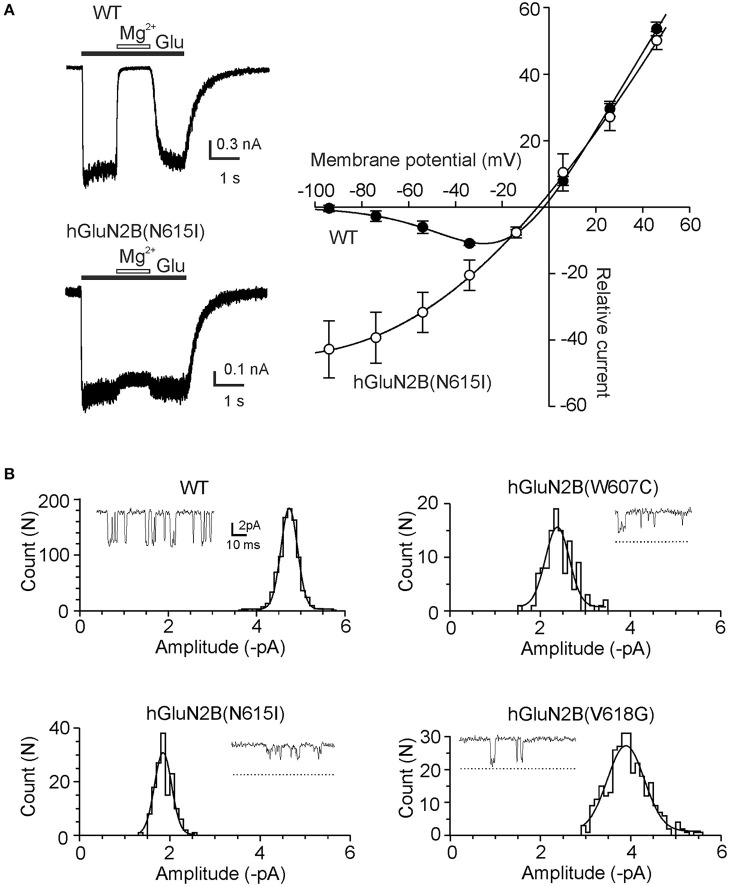
Mutations in the channel pore alter ion permeation. (A) Effect of Mg2+ on WT and hGluN1/GluN2B(N615I) receptor responses. Whole-cell current responses were induced by 1 mM glutamate in the absence and presence of 1 mM Mg2+ at a holding potential of −60 mV. I-V relations without Mg2+ were fit by a linear equation and normalized to have a slope of 1. Corresponding responses recorded in the presence of Mg2+ were normalized and fitted to the Boltzmann equation (Equations 6–8). (B) Examples of single-channel openings induced in WT, hGluN1/hGluN2B(W607C; N615I; and V618G) receptors by 1 mM glutamate. Dashed lines show where the current levels identified from the fit to the amplitude distribution for the WT would fall. For individual patches the distribution is shown fitted with a single Gaussian component. Glutamate-induced single-channel currents had mean amplitude: −4.7 pA (WT), −2.4 pA [hGluN1/hGluN2B(W607C)], −1.9 pA [hGluN1/hGluN2B(N615I)], and −3.9 pA [hGluN1/hGluN2B(V618G)].